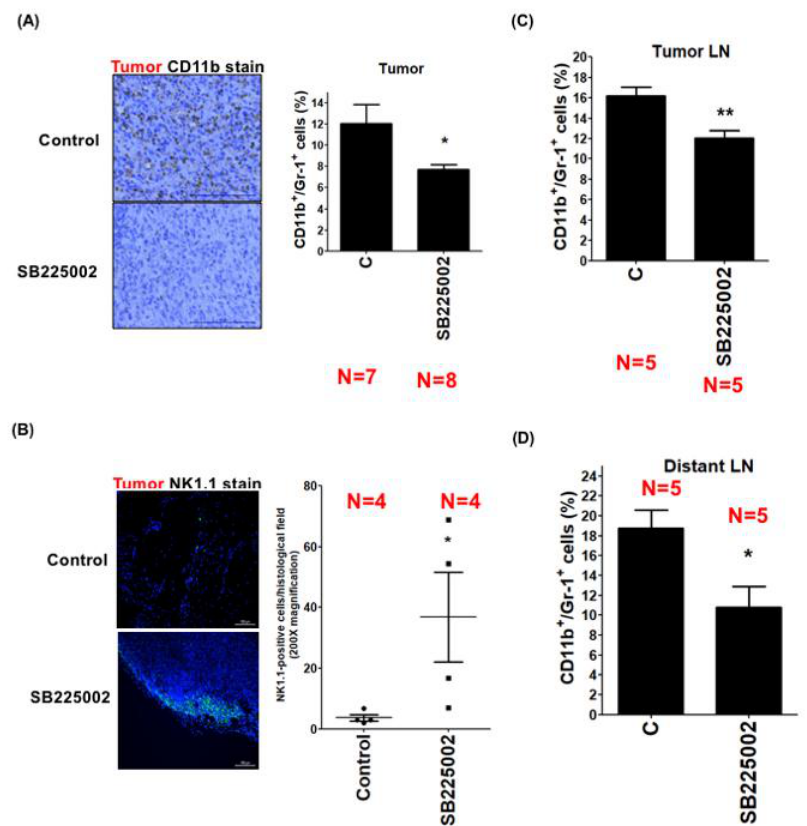
Figure 4. LEC-released chemokines promote myeloid-derived suppressor cell (MDSC) recruitment in the lymph nodes via CXCR2. ( A ) LC cells were injected into the mammary fat pads of nude mice. After one week, mice were treated with vehicle (control) or CXCR2 inhibitor SB225002 for another three weeks. The amount of CD11b + / Gr-1 + MDSCs in the tumors was investigated by flow cytometry. Scale bar: 50 µ m. ( B ) The number of NK1.1-positive natural killer (NK) cells in the tumors was determined by immunofluorescent staining. Scale bar: 50 µ m. ( C ) The amount of CD11b + / Gr-1 + MDSCs in the tumor-draining lymph nodes was investigated by flow cytometry. ( D ) The amount of CD11b + / Gr-1 + MDSCs in distant lymph nodes was investigated by flow cytometry. * p < 0.05; ** p < 0.01 .